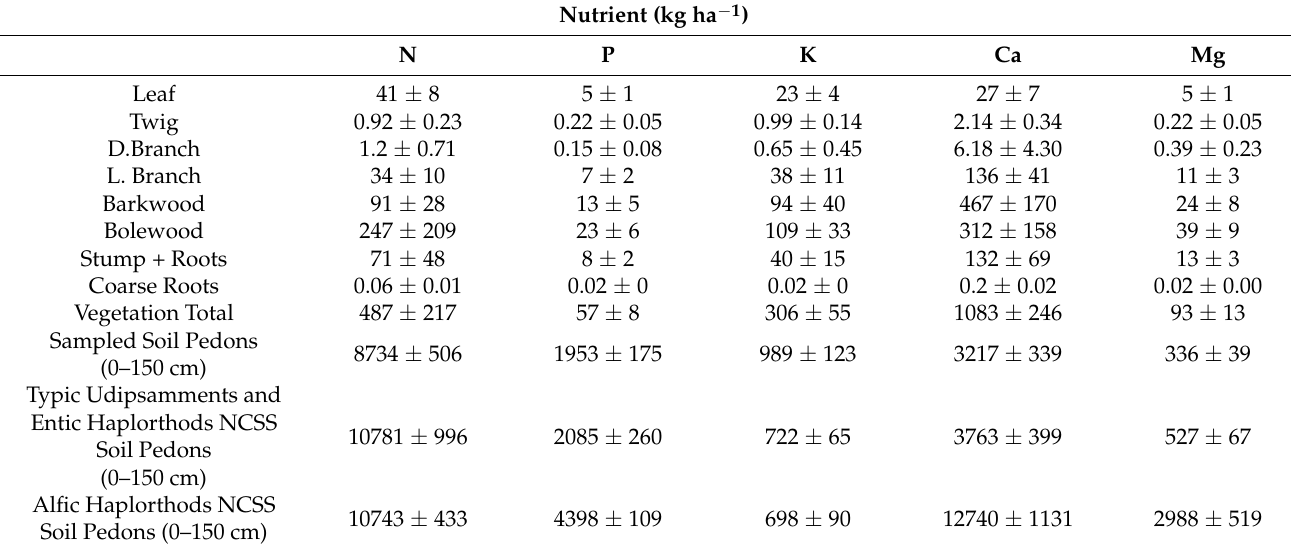
Table 1. Distribution of nutrient pools in an aspen-dominated forest located on nutrient-poor soil types and confidence intervals ( α = 0.05). Average vegetation nutrient pools are adjusted to 45 years old in the summer